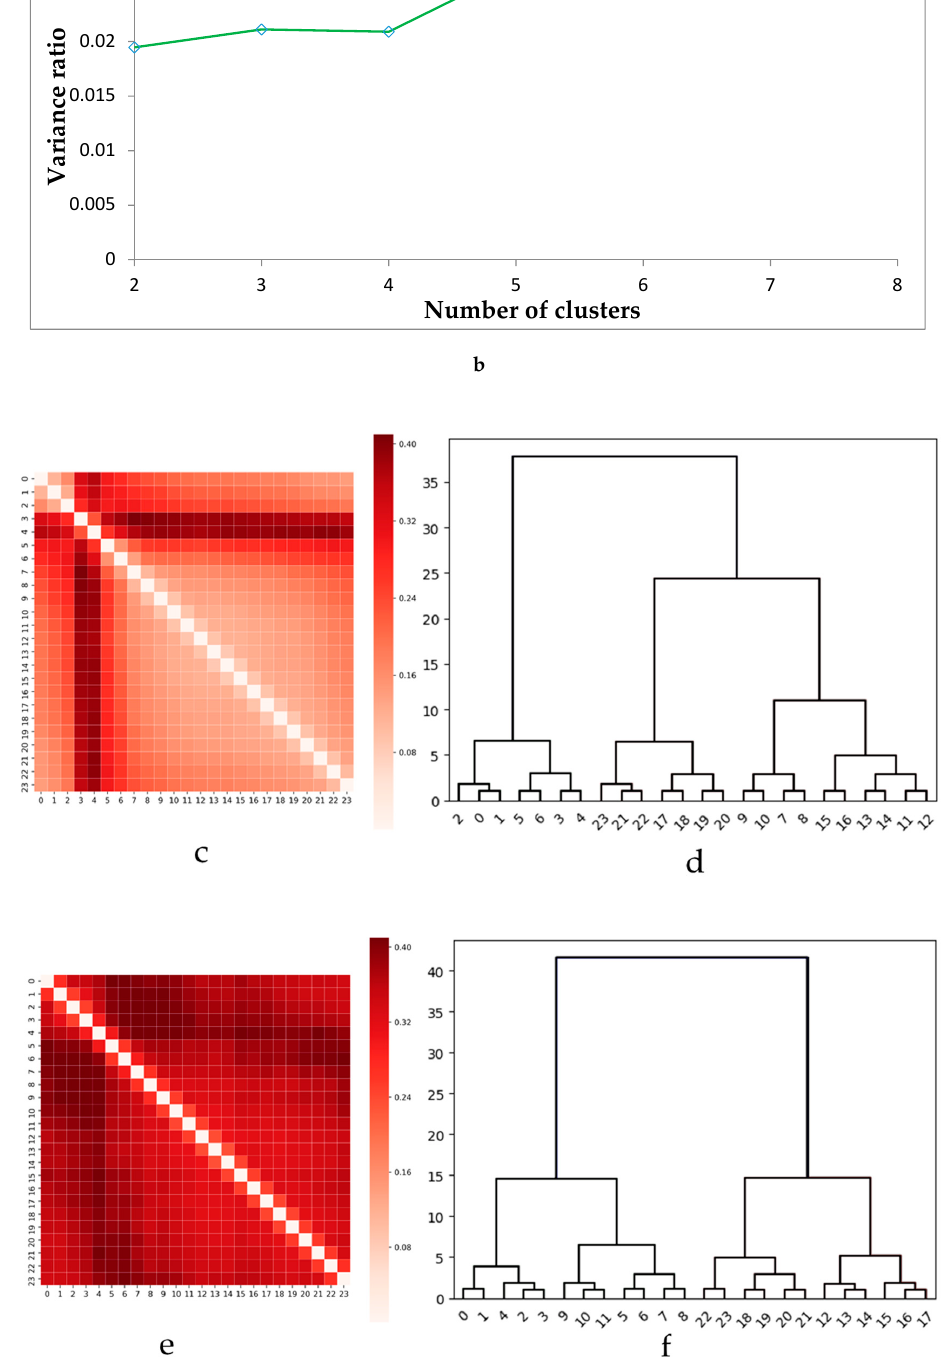
Figure 5. Layer aggregation of Spatial-Interaction Networks of Beijing (SINB). ( a ) Ratio of within-cluster variance to total variance for each possible choice of k (number of clusters) on weekdays; ( b ) ratio of within-cluster variance to total variance for each possible choice of k (number of clusters) on weekends; ( c ) dissimilarity matrix between snapshots on weekdays; ( d ) hierarchical clustering on weekdays; ( e ) dissimilarity matrix between snapshots on weekends; and ( f ) hierarchical clustering on